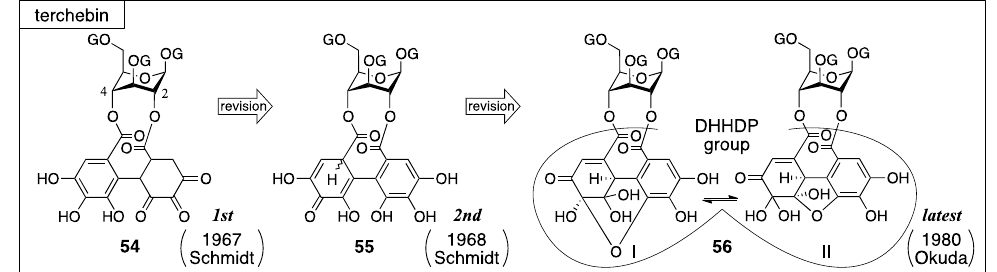
Figure 23. The transition of the structure of terchebin.